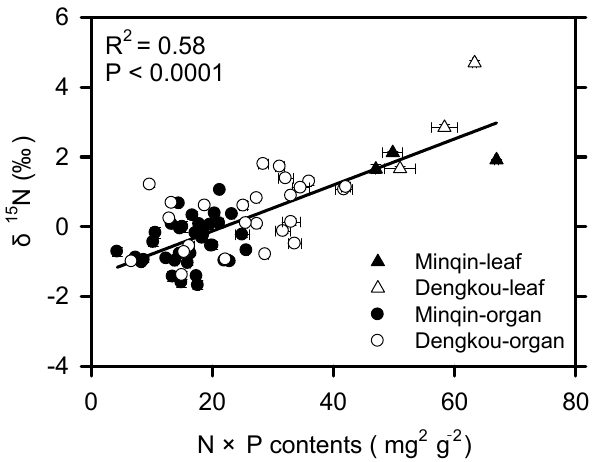
Figure 4. Changes of δ 15 N as a function of the product of organ N × P contents. Filled and unfilled symbols represent organs at the Minqin and Dengkou site, respectively. Leaves are denoted by filled or unfilled triangles while other organs by filled or unfilled circles.